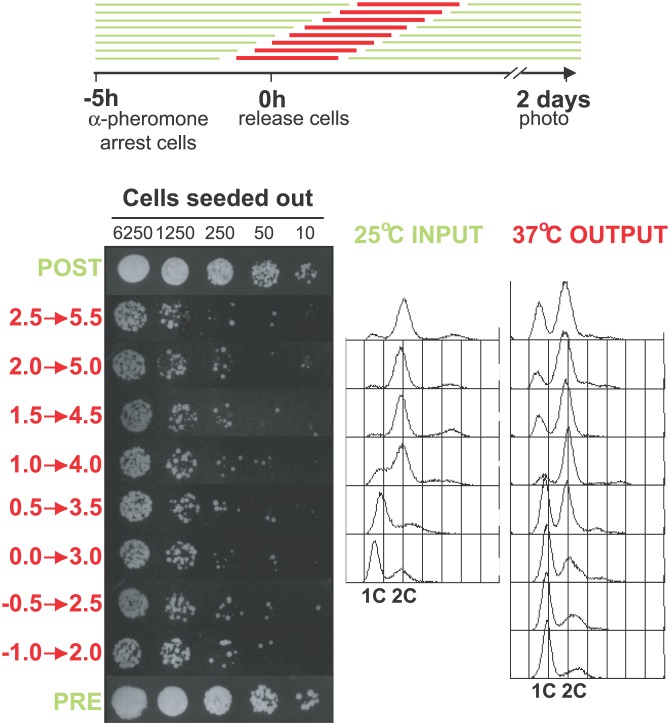
RSC Is Essential during G1The MatA, Pgal::UBR1, sth1td, rsc6td, rsc8td strain (YN286) was synchronized in G1 by incubation in α-pheromone (10 μg/ml final) as indicated in the time line (top panel). Incubations at permissive and nonpermissive temperatures are represented by green and red lines, respectively. The α-pheromone was washed out after 5 h and aliquots of cells were shifted from the master culture to 37 °C for 3-h periods as indicated (top panel). CFUs were visualized by seeding 5-fold serial dilutions onto YEP-glucose + CuSO4 plates followed by incubation at 25 °C for 3 d. DNA content was determined by FACS analysis. FACS samples were also taken after 5 h at 37 °C and gave identical profiles as the 3-h samples, indicating that terminal cell-cycle arrests had been reached after 3 h at 37 °C (unpublished data). The “pre” and “post” samples show viability in the 25 °C master culture before and after the experiment, respectively.